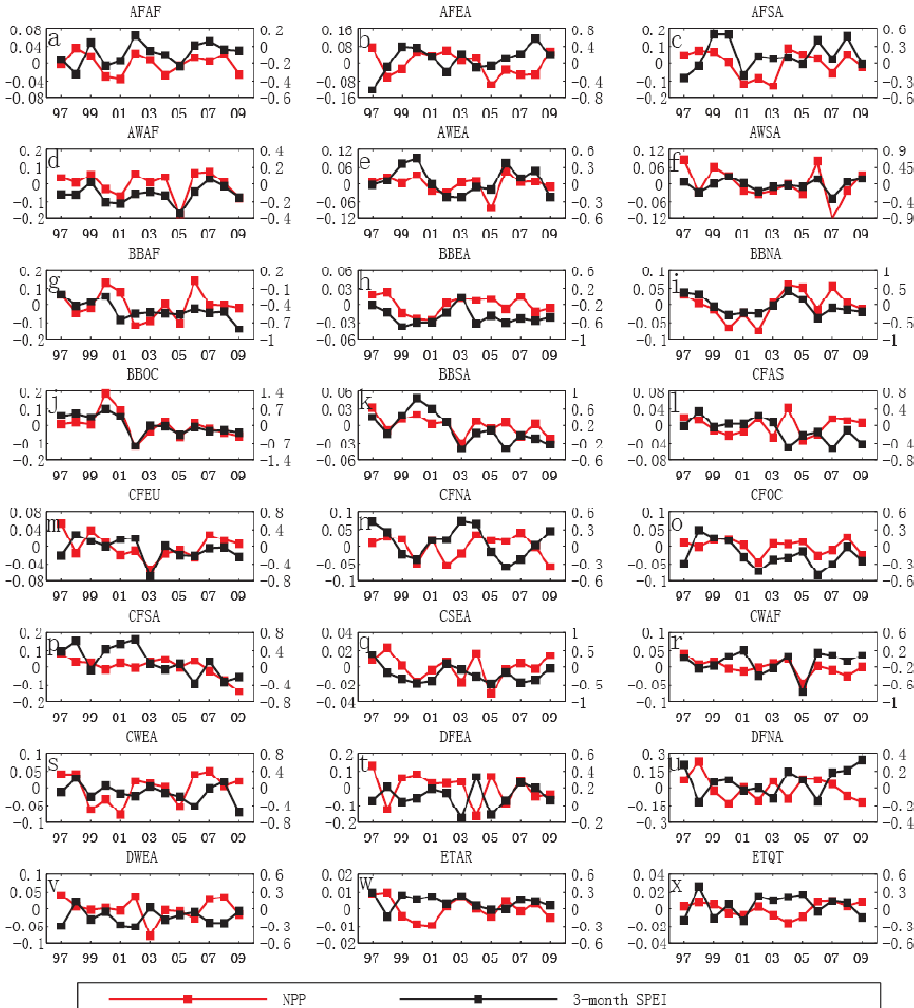
Fig. 4. Regional average of SPEI and NPP anomalies for the 24 regions listed in Table 1.